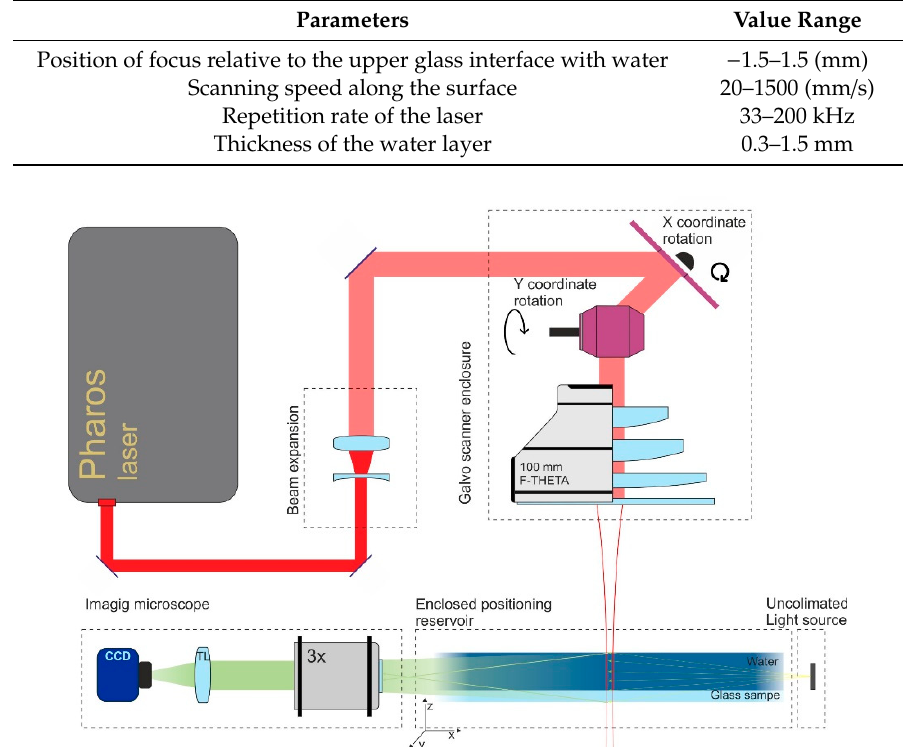
Figure 1. Micromachining setup. The laser beam is directed by a scanner and is focused using an f-theta lens (f = 100 mm) onto the sample that is covered with a thin layer of f-theta lens (f = 100 mm) onto the sample that is covered with a thin layer of water.